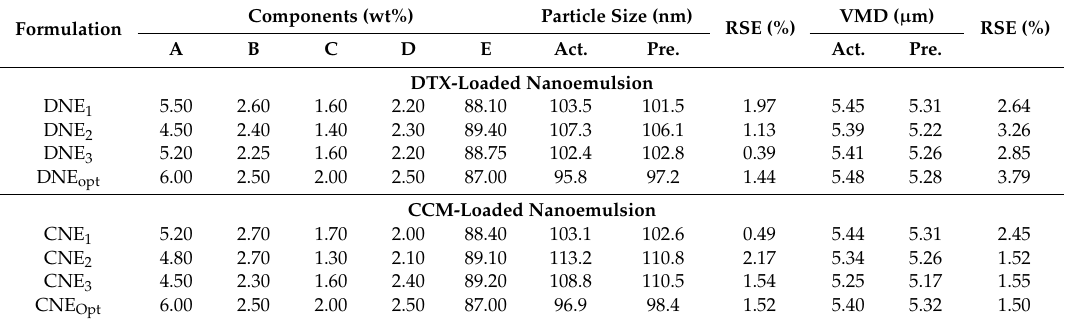
RSE: residual standard error; Act: actual; Pre: